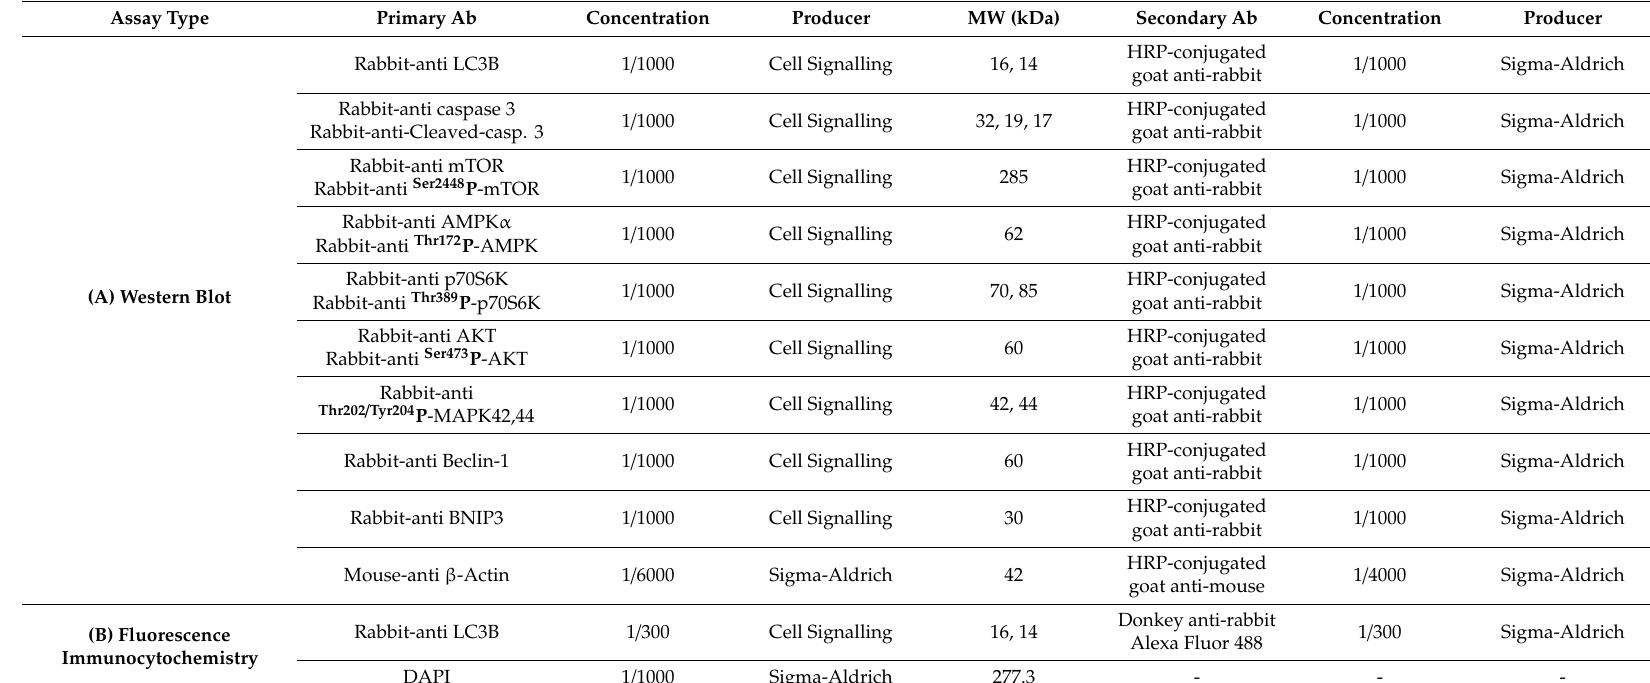
Table 1. Antibodies (Ab) used for western blot and immunocytochemistry